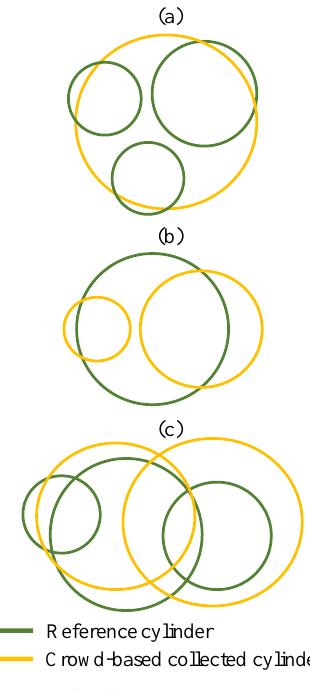
Figure 4. Examples of different relationships between reference data and crowd-based collected data: (a) n :1 relationship: three reference cylinders are collected with one cylinder by a crowdworker (b) 1: n relationship: one reference cylinder is